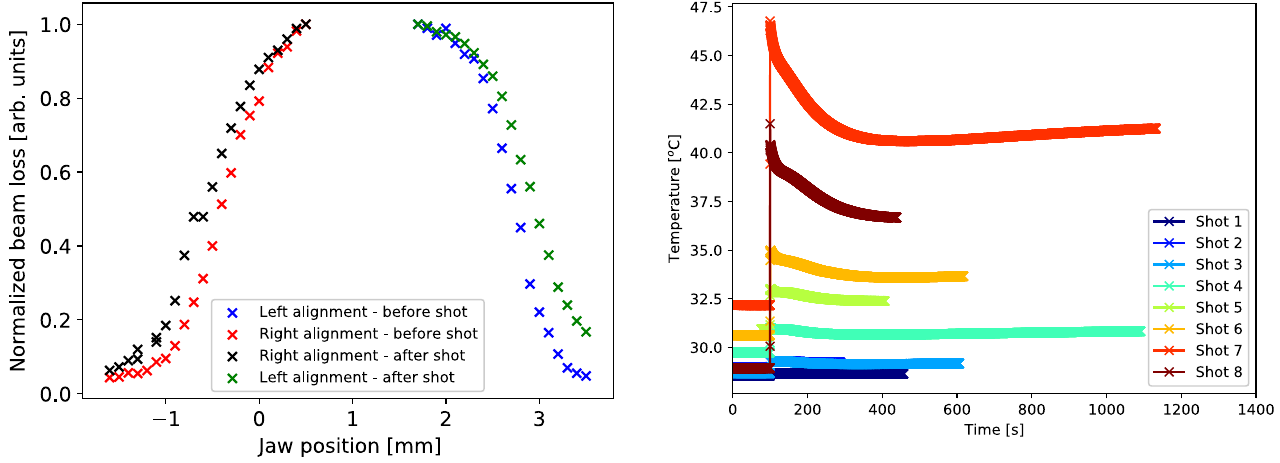
FIG. 21. Temperature measurements acquired from the left- upstream jaw corner probe during the eight shots, superimposed over each other and synchronized in time.